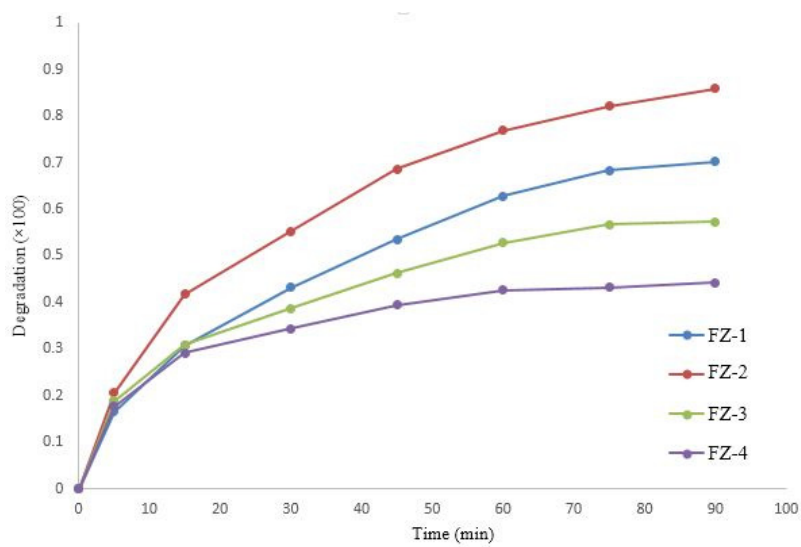
Fig. 3. The catalytic activity of Fe-ZSM-5 samples in phenol